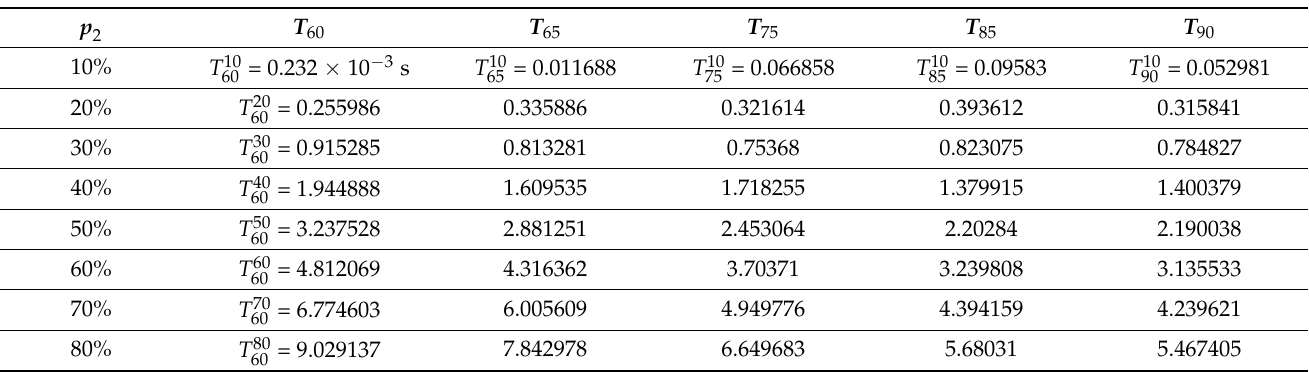
Table 2. Mean extra travel time data.